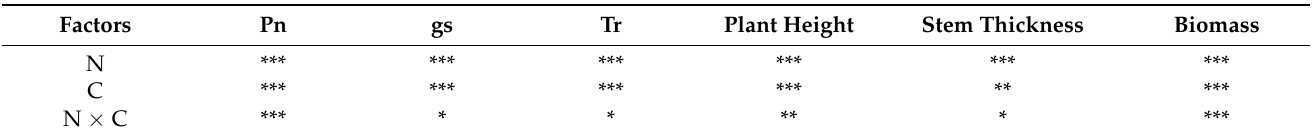
Table 3. Output of two-way ANOVA of leaf gas exchange parameters, tomato growth, and biomass as affected by N (N1, N2, N3, N4) and biochar (C0, C30, C50, C70).